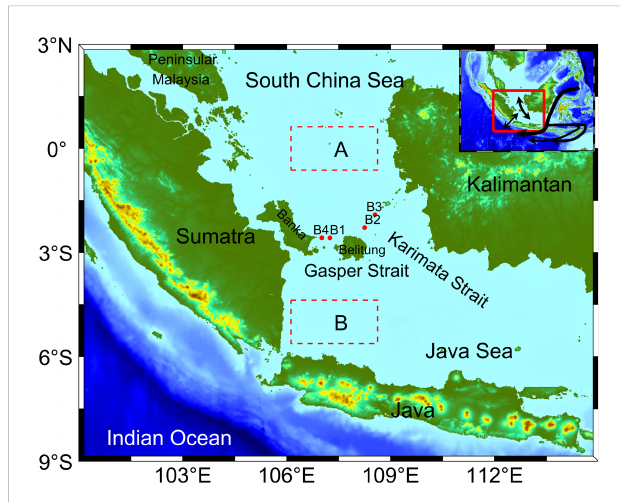
FIGURE 1 Study region and the observation sites in the KS. (A, B) are the areas selected to calculate the sea surface height